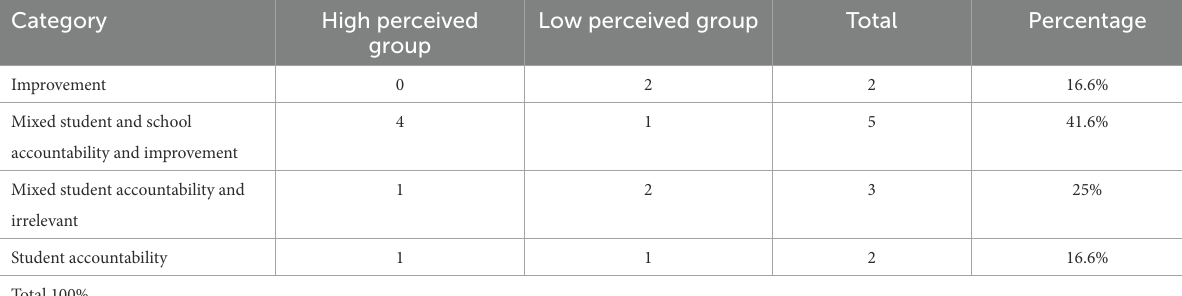
TABLE 3 Distribution of conceptions between